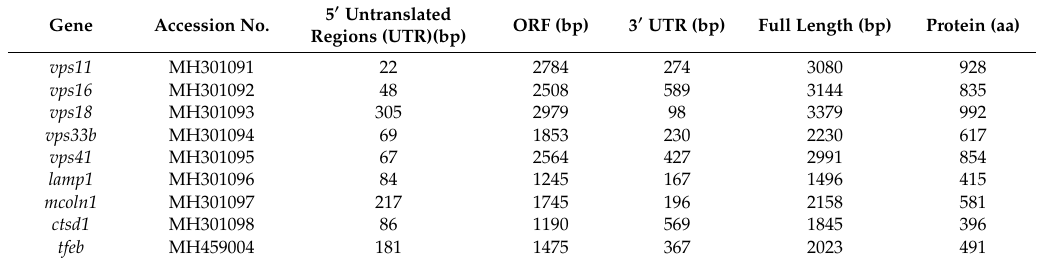
Table 1. The sequence information of autolysosome-related genes from P. fulvidraco.